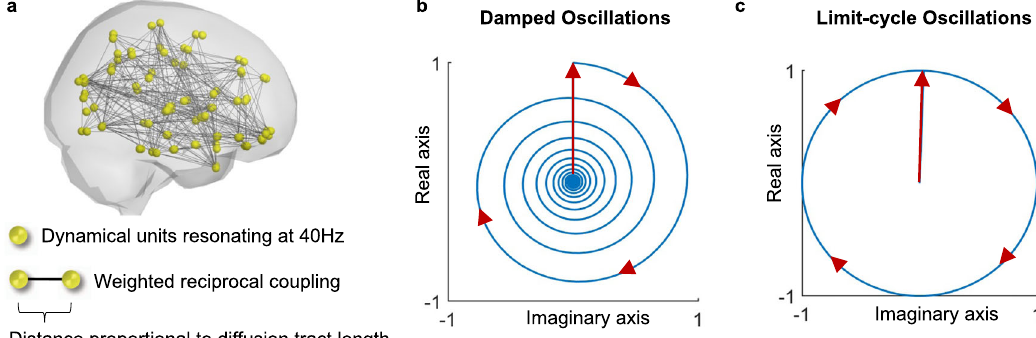
Fig. 1 Reducing the brain to a system of oscillators coupled in Connectome spacetime structure. a The phenomenological brain network model consists in N = 90 nodes representing brain regions with links representing diffusion tracts between them. b A Stuart – Landau oscillator in the subcritical regime responding to perturbation (vertical arrow) with an oscillation with decaying amplitude. c In the supercritical regime, the Stuart – Landau oscillator enters a limit-cycle (with constant amplitude), approximating a phase